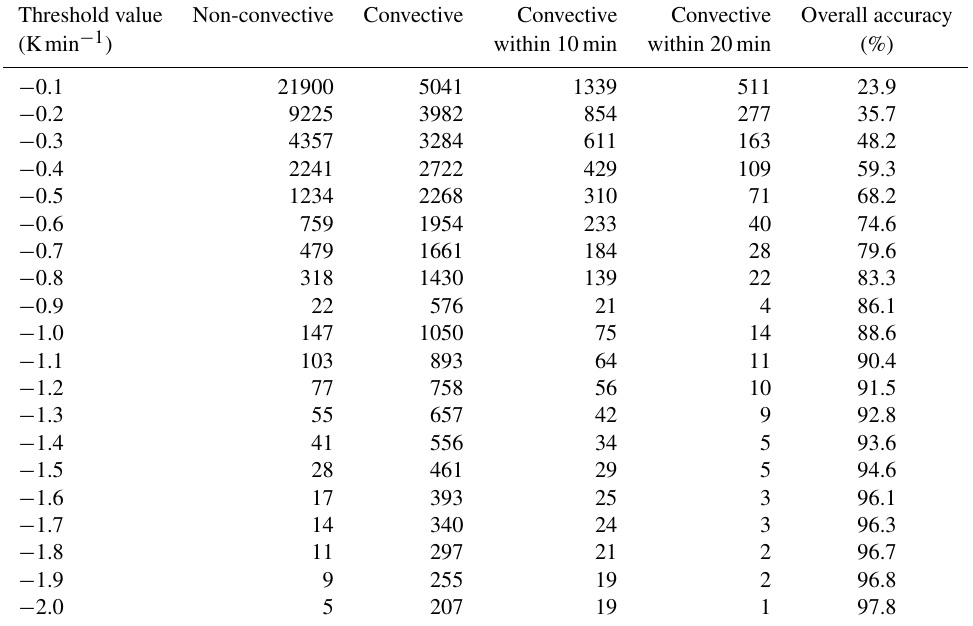
Table 2. Number of non-convective, convective, convective within 10min, and convective within 20min for using different threshold values (Channel